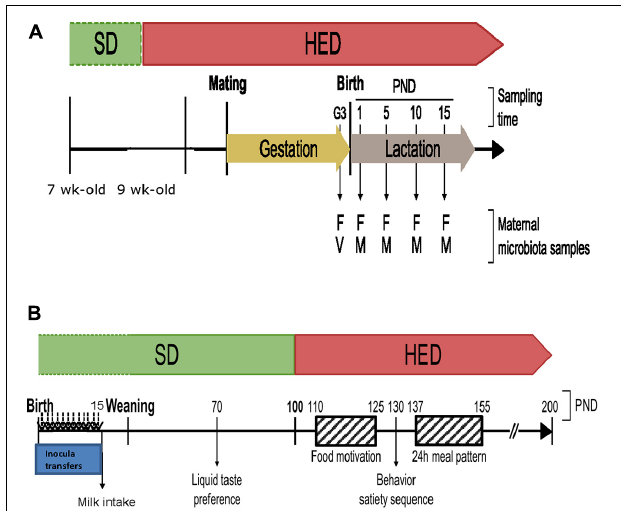
FIGURE 1 | (A) Timeline of maternal microbiota collection from OP and OR dams to produce inocula. Vaginal microbiota (V) was collected at the end of the third week of gestation (G3). Milk microbiota (M) was collected every 5 days from postnatal day (PND)1 to PND15. Fecal microbiota (F) was collected at every time point. (B) Inocula transfers and timeline of behavioral tests performed on Fischer pups before and after